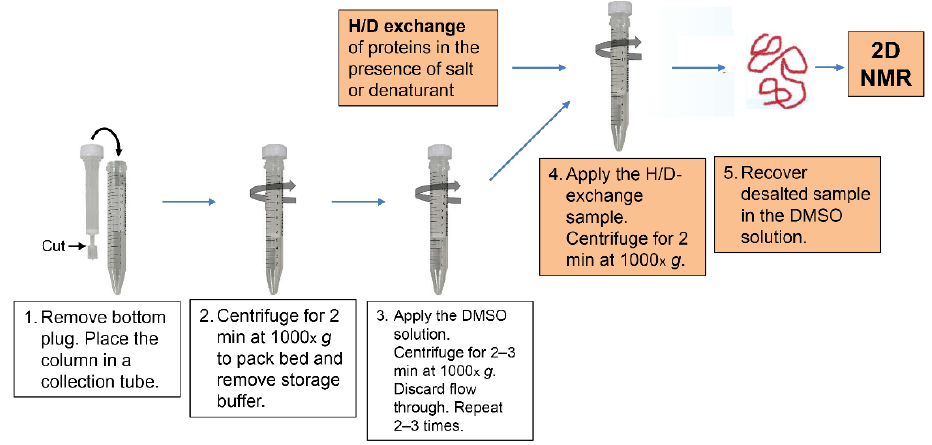
Figure 1. A schematic procedure of the medium exchange by a spin desalting column. We used 2D 1 H– 15 N HSQC spectra for the NMR analysis, and hence the sample protein was 15 N-labeled, and the assignment of the HSQC cross peaks was carried out by three-dimensional (3D) HN(CA)NNH, HNCA, HN(CO)CA, HNCO, CBCA(CO)NH, and HNCAHA experiments using 13 C/ 15 N-double-labeled proteins. We applied the improved DMSO-quenched 2D NMR method to investigate the H/D-exchange behavior of the E. coli co-chaperonin GroES at pH* 6.5 (or 7.5) and 25 ◦ C [135] and unfolded ubiquitin at